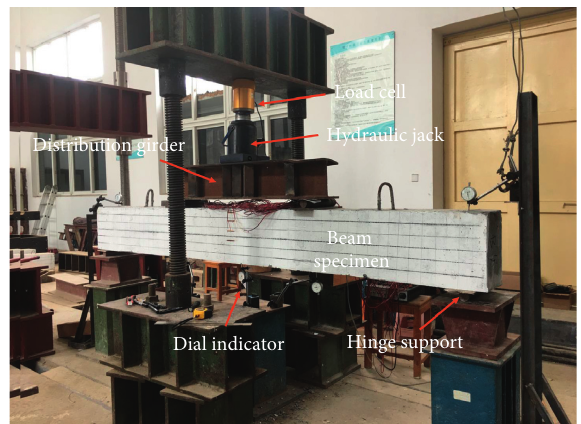
Figure 4: Loading